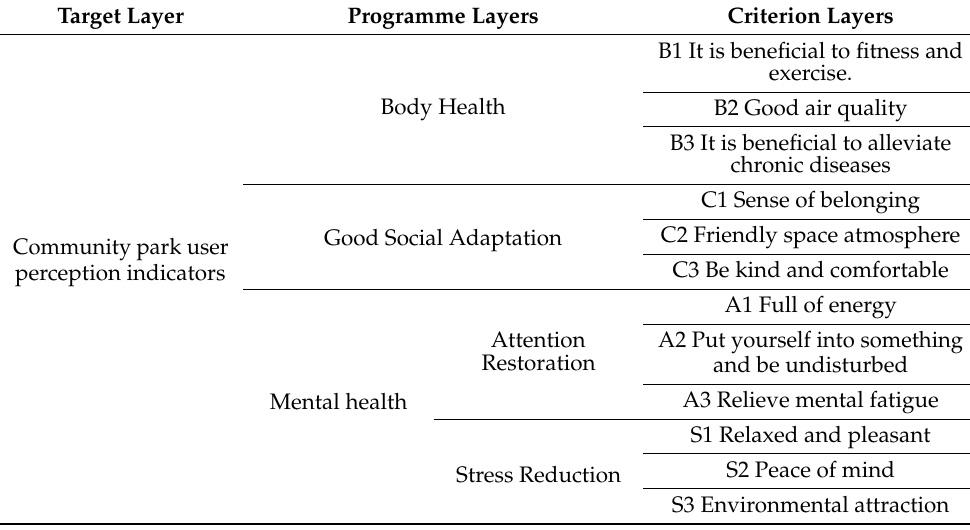
Table 2. Evaluation indicators of feelings of community park